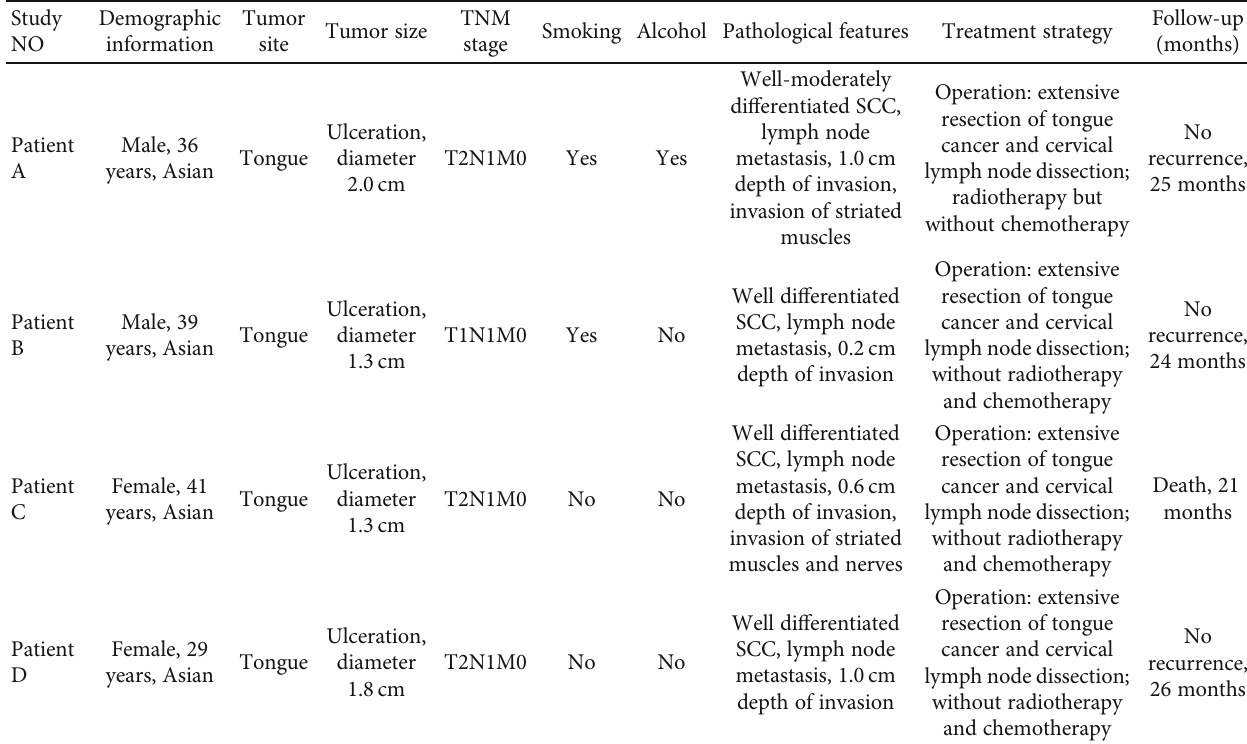
Table 1: Clinicopathological characteristics of the 4 included patients.